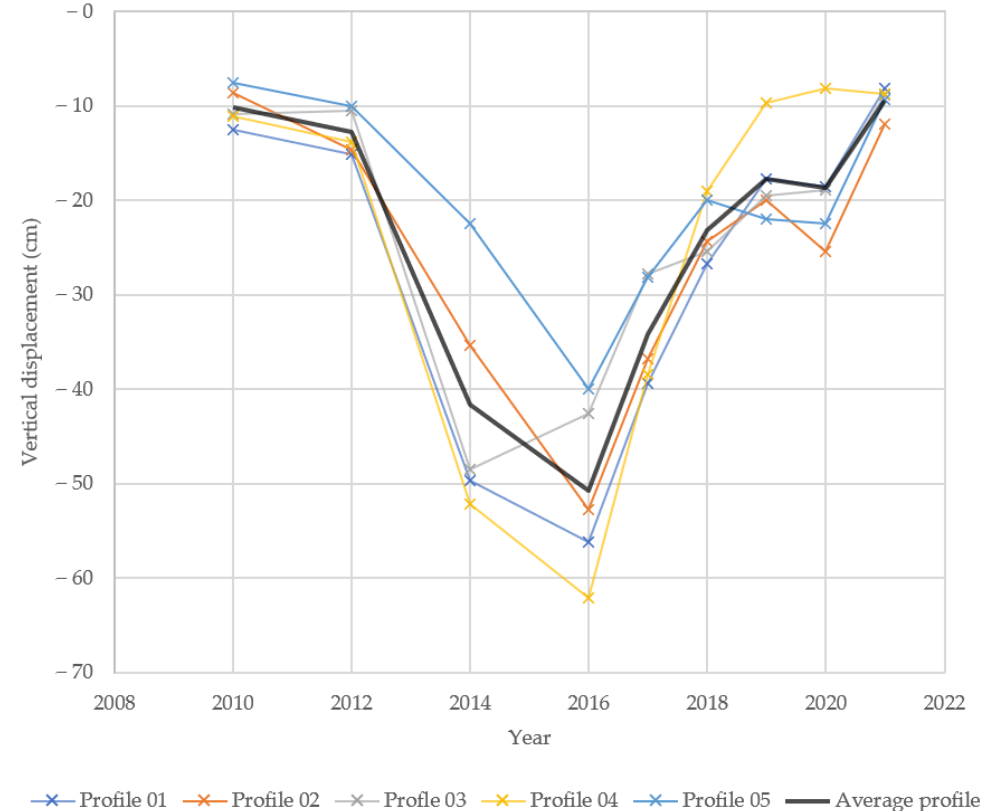
Figure 7. Relative subsidence values in MP 03.